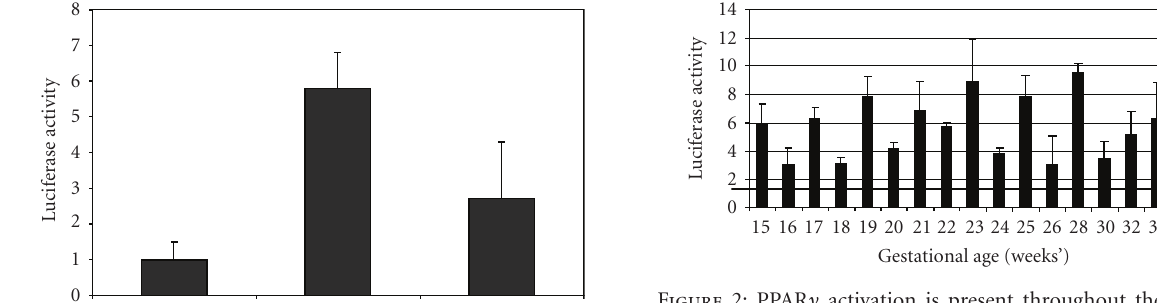
Figure 2: PPAR γ activation is present throughout the course of normal pregnancy. All serum samples were collected from the same subject and PPRE-luciferase reporter experiments were performed using 10% serum as described in Figure 1. Luciferase activity was normalized to DCSS to determine relative activation. Black hori- zontal bar represents the level of signaling seen with 10% serum from the same woman six weeks after